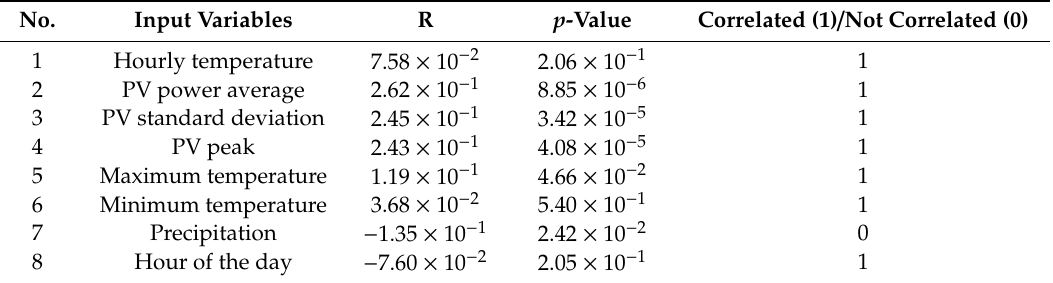
Table 1. Correlation coe ffi cients of the input variables.